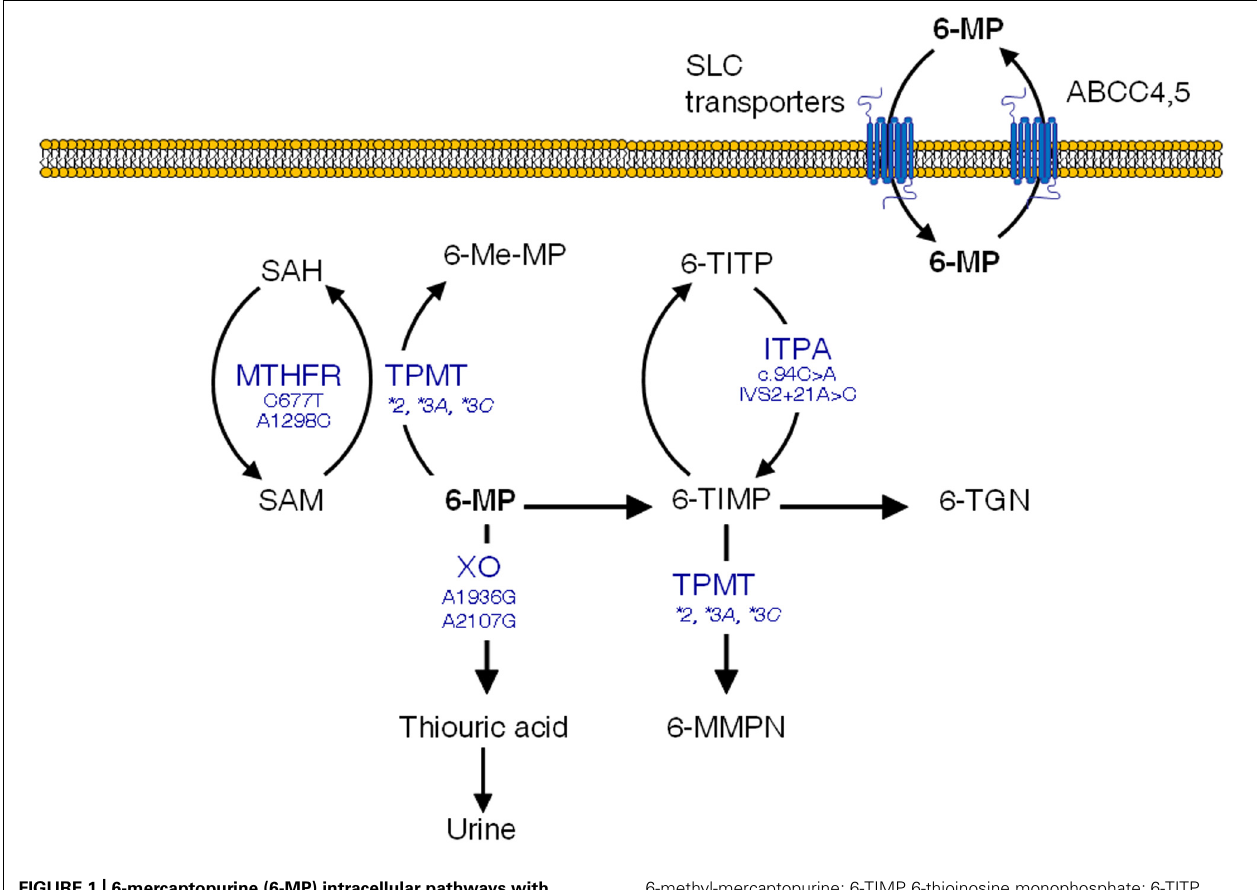
6-methyl-mercaptopurine; 6-TIMP, 6-thioinosine monophosphate; 6-TITP, 6-thioinosine triphosphate; ITPA, inosine triphosphate pyrophosphatase; 6-MMPN, 6-methyl-mercaptopurine nucleotides; 6-TGN, 6-thioguanine nucleotides